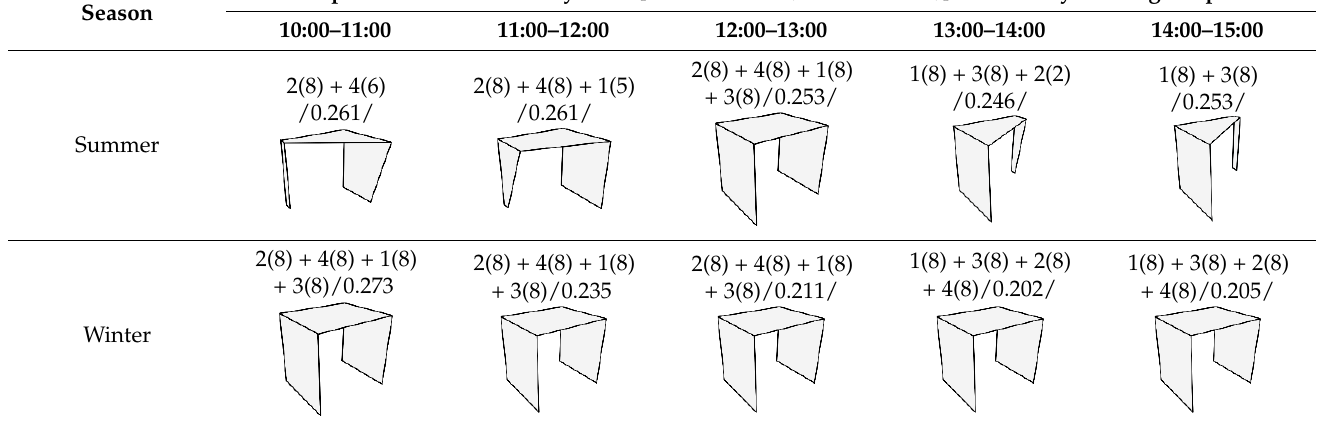
Table 6. Optimal specifications and uniformity for each period in Case 5 for improving indoor uniformity.